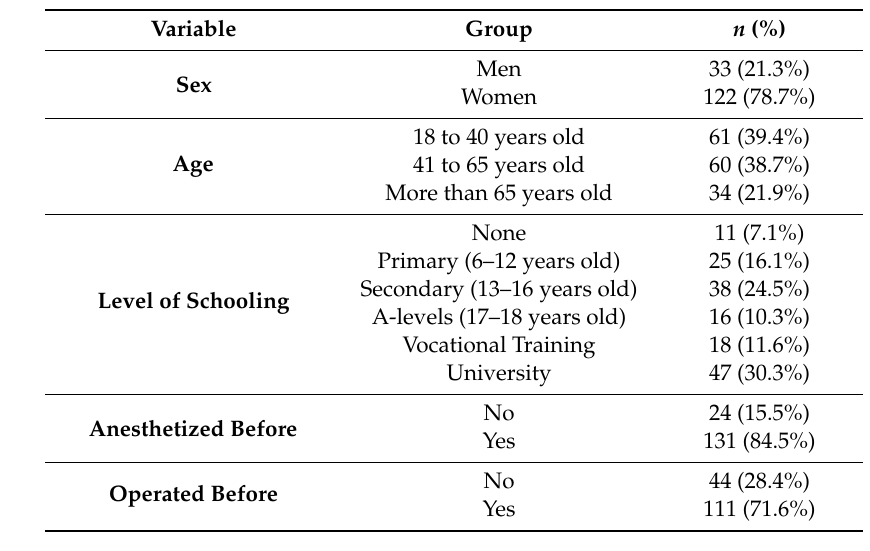
Table 1. Sociodemographic characteristics.